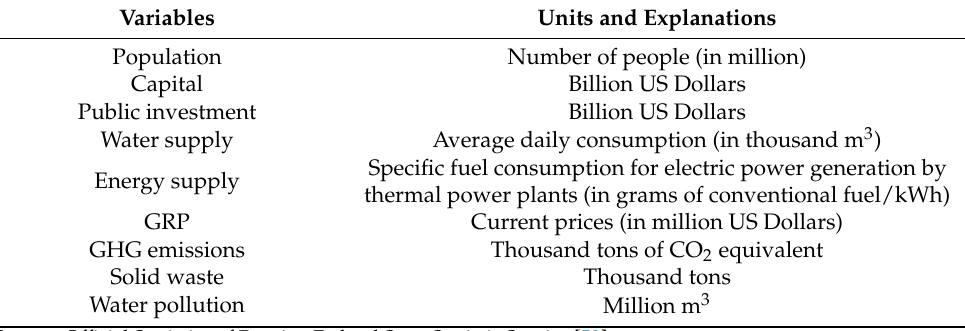
Table 2. Descriptive statistics of the inputs and outputs of